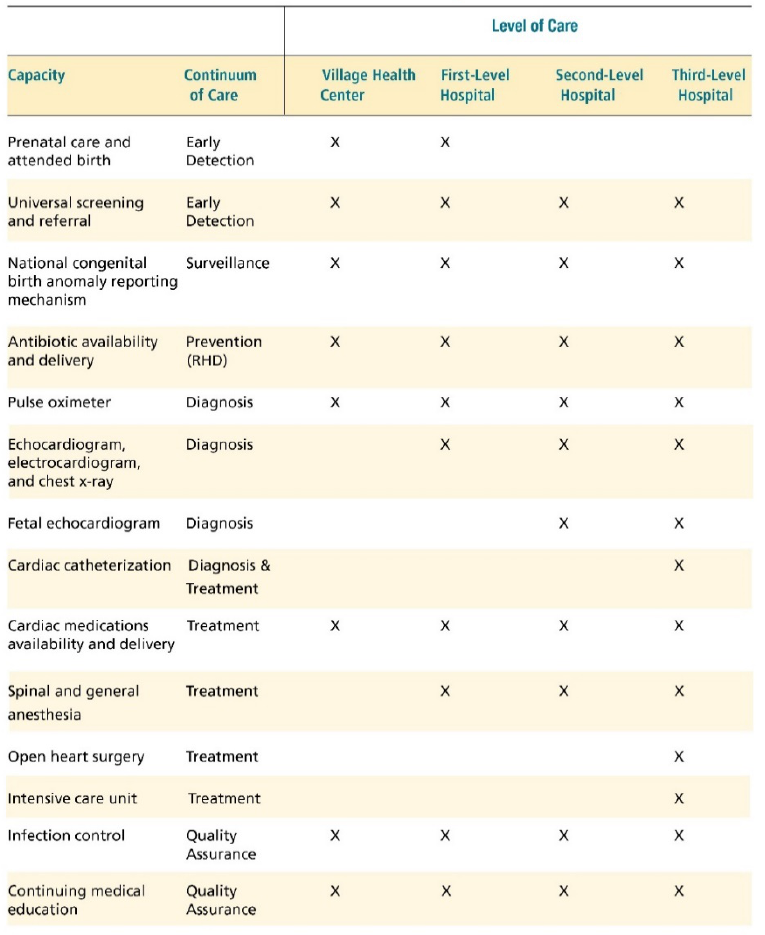
Figure 2. Pediatric cardiac care in an ideal health system. (X denotes service needed at that level)